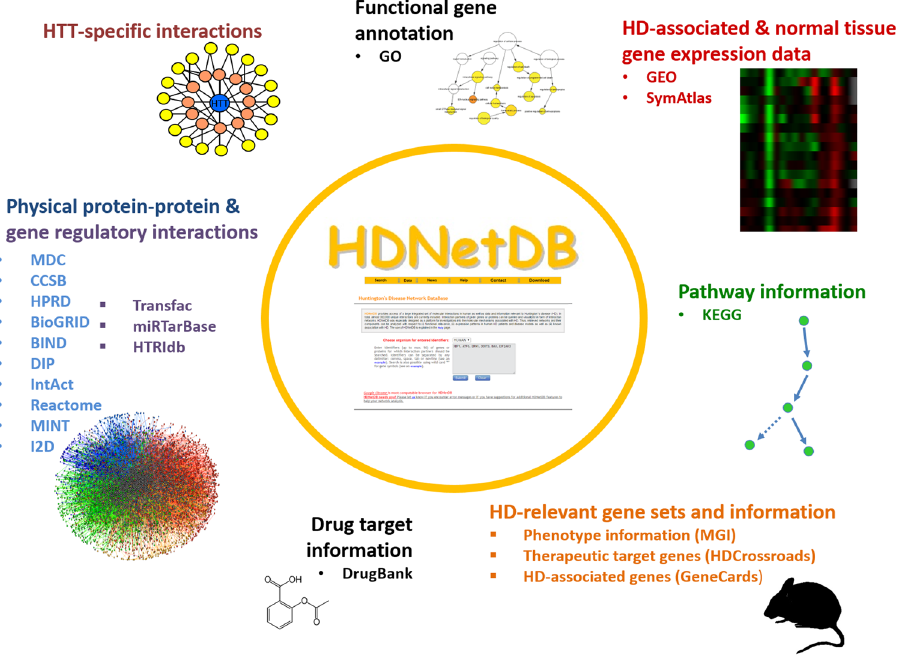
Figure 1. Data and information integrated in HDNetDB. Many types of complementary data and information can be accessed, analyzed and visualized in HDNetDB. While the incorporation of generic data like the